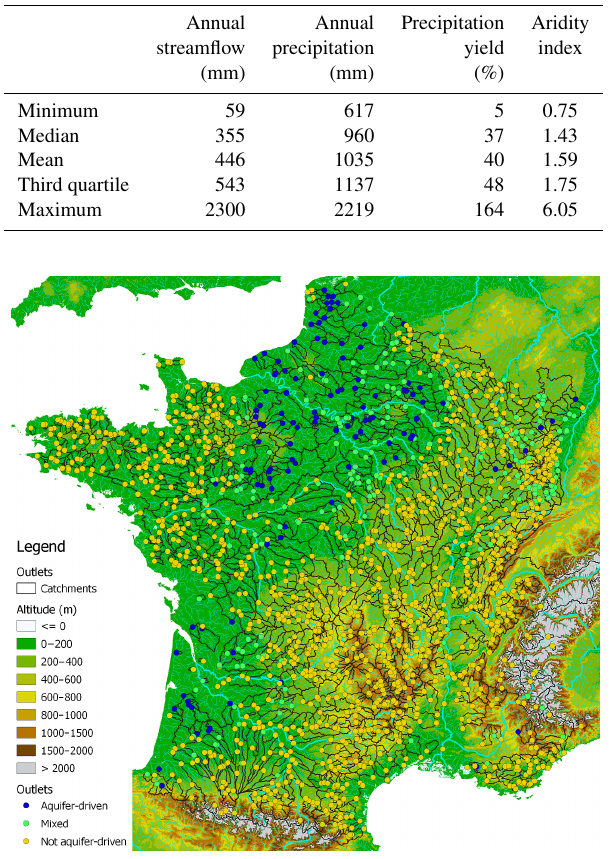
Figure 2. Map of the catchments in the dataset. Dots represent the outlet of each catchment, with different colours according to the type of aquifer influence used in Fig. 8.